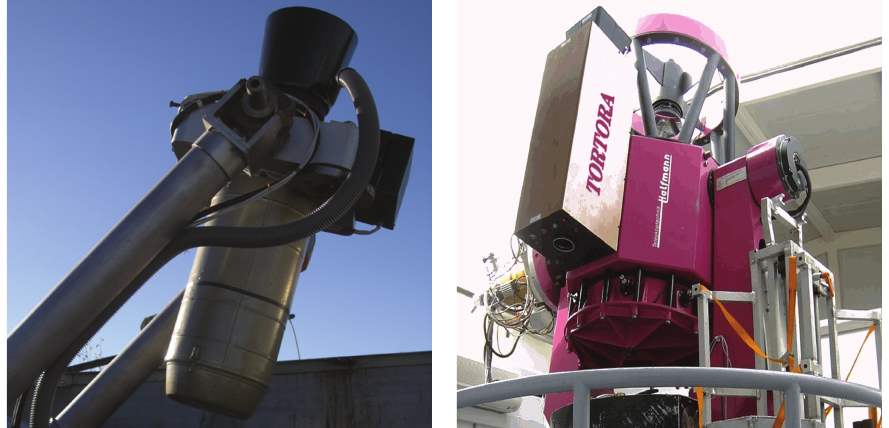
Figure 2: Images of prototype fast wide-field FAVOR camera, located in the Special Astrophysical Observatory of Russian Academy of Sciences at North Caucasus, and the TORTORA camera, mounted on top of the REM robotic telescope in La-Silla Observatory, ESO, Chile.